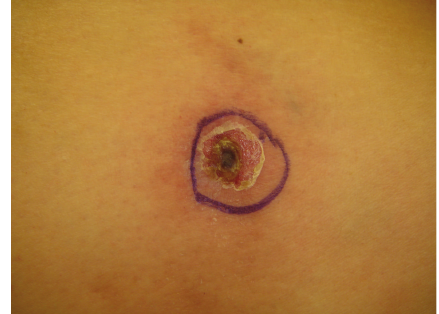
Figure 1: The appearance of our patient’s bilateral thigh wounds showing firm cutaneous lesions that were exquisitely tender. The lesions are located in the proximal lower extremity on the lateral aspects of the thighs.